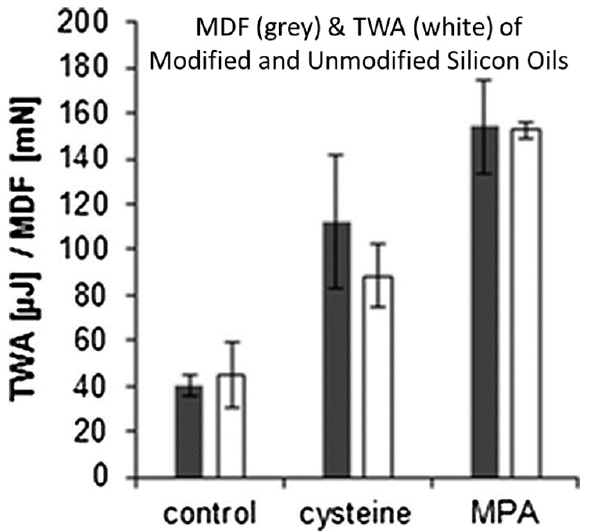
Figure 11. Maximum detachment force (MDF, gray bars) and total work of adhesion (TWA) were calculated as the area under the force versus displacement curves. Reprinted with permission [72]. Copyright (2015) Elsevier.